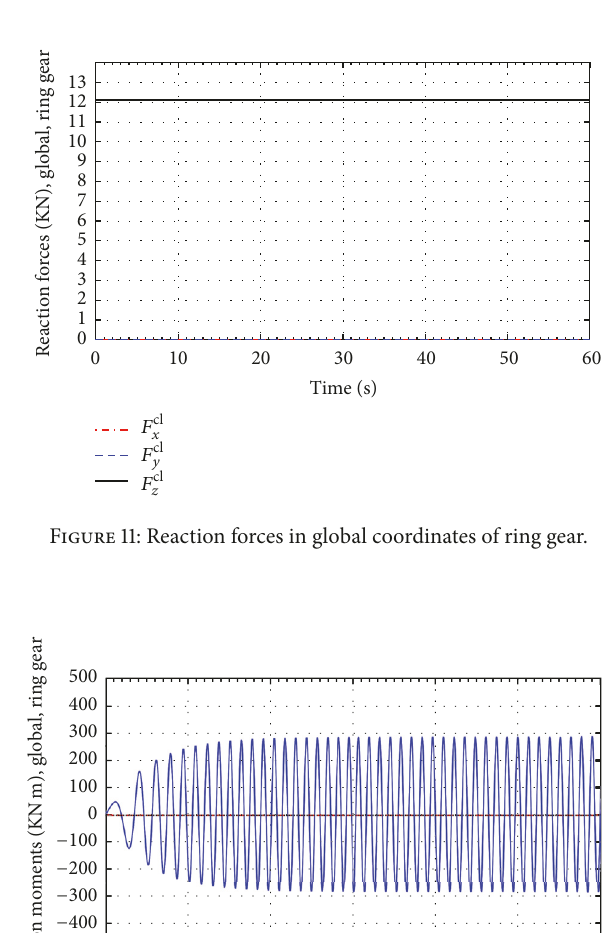
Figure 9: Nonzero Lagrange multipliers due to fixed ring gear.